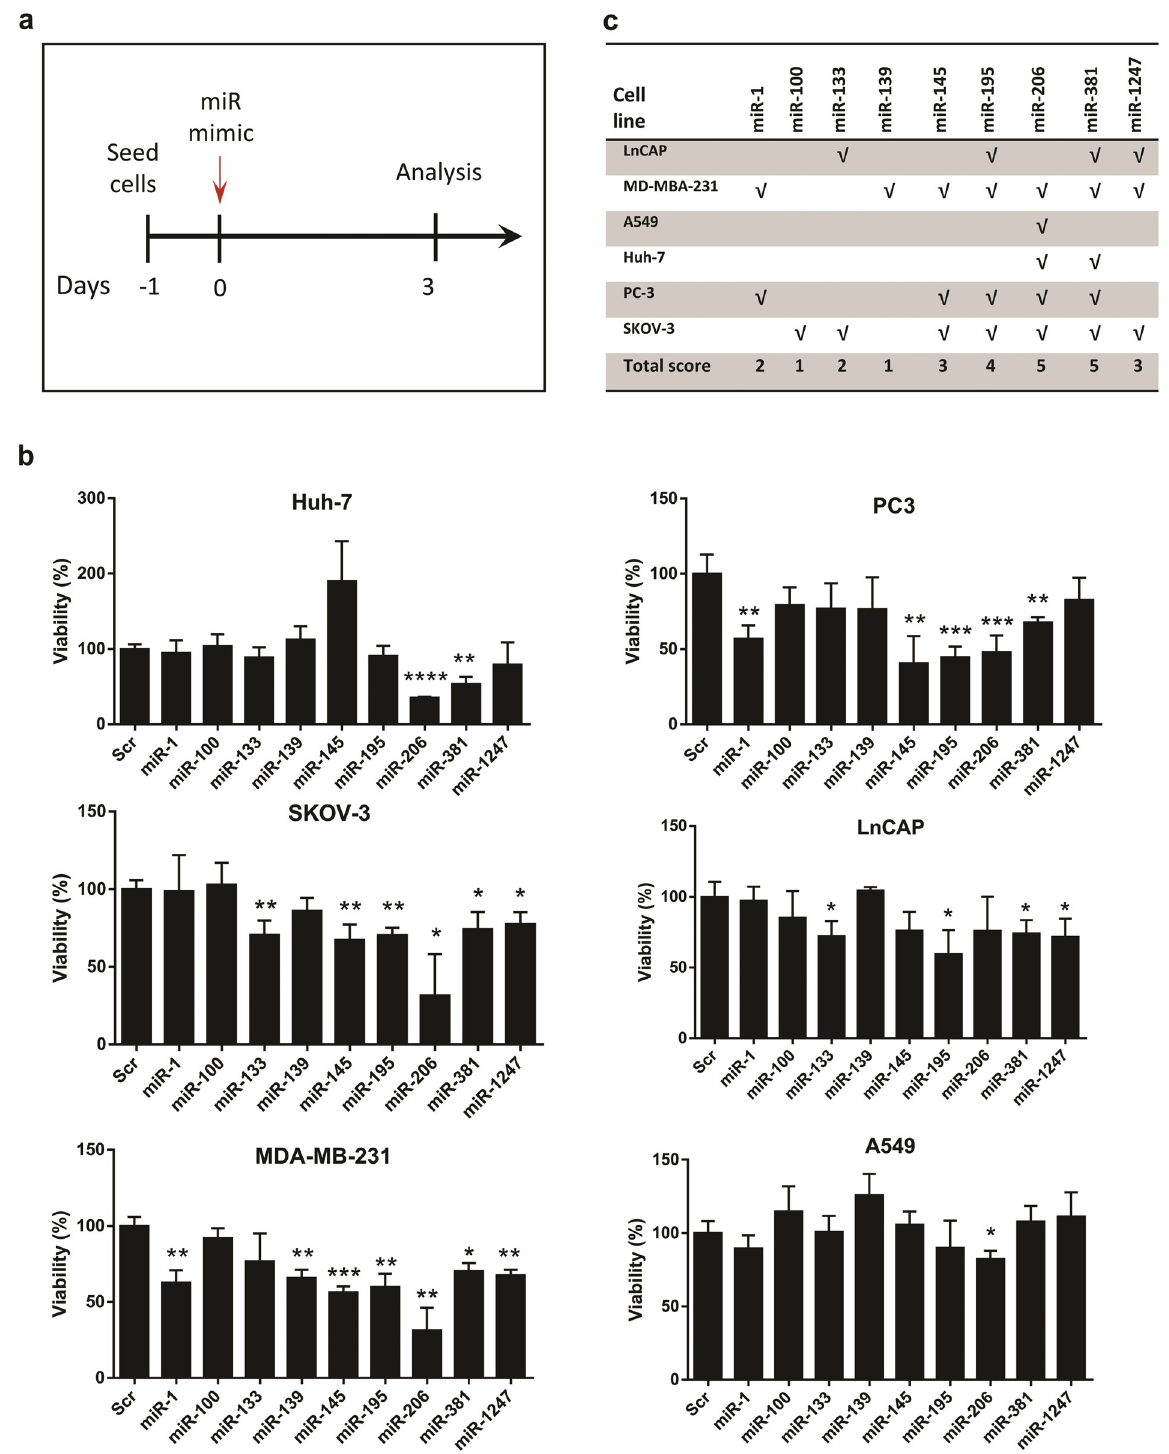
Fig 5. Gain of function of nine candidate normomiRs in six cancer cell types. ( a ). Schematic showing the procedure of cancer cell analysis following treatment with candidate normomiRs. ( b ). MTS viability assays of different cancer cell lines three days after transfection with candidate normomiRs. Data are shown as mean ± SEM, n = 3–5, � p < 0.05; �� p < 0.001; ��� p < 0.0001; ���� p < 0.0001. ( c ). Summary of the results shown in (B). Huh-7: human hepatoma (hepatocellular carcinoma) cell line; PC3: prostate cancer 3 cell line, SKOV-3: an ovarian cancer cell line originally derived from ascites of a female patient with ovarian cancer; LnCAP: a prostate cancer cell line originally established from a metastatic